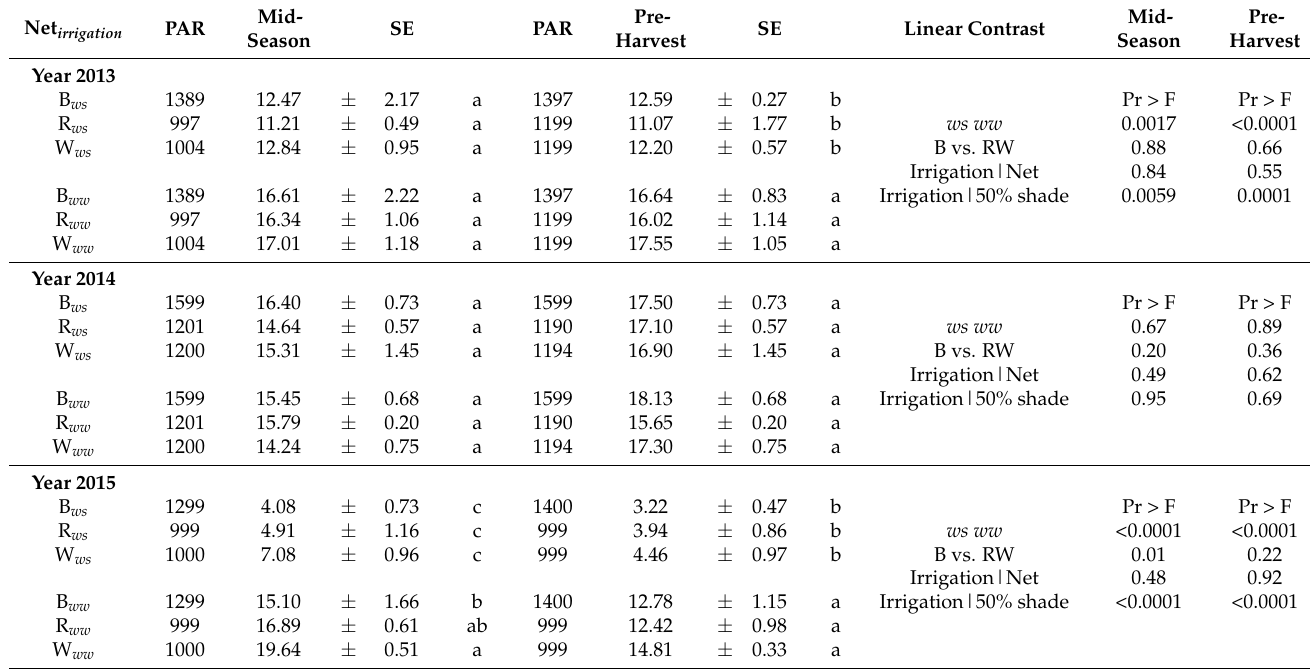
Table 2. Midday leaf photosynthesis values in two periods of the season (mid-season and pre-harvest) for net irrigation treatments during the years 2013, 2014, and 2015. The interaction between treatments and crop load was not found to be significant, thus each value is the result of a simple ANOVA (mean of 4 trees). PAR values are reported and means are followed by standard error. The presence of different letters indicates significant differences at 95%, according to an SNK test. On the right side of the table, linear contrast F values for the two analyzed periods are shown; values below 0.05 are considered